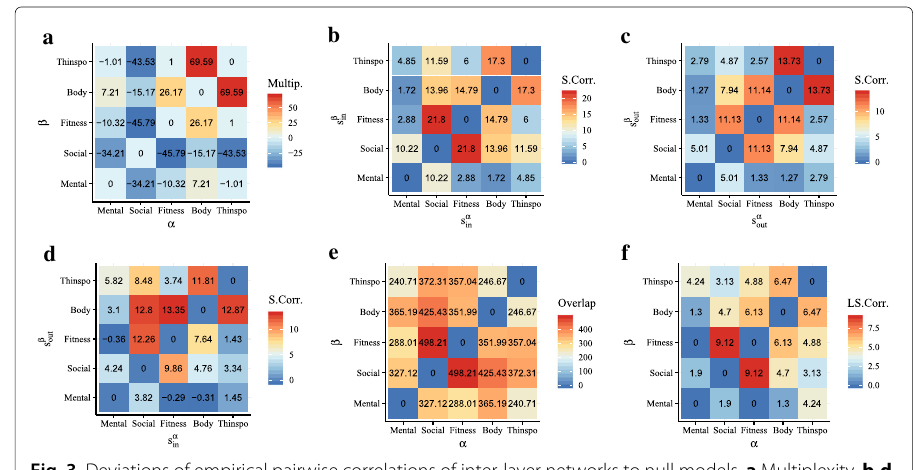
Fig. 3 Deviations of empirical pairwise correlations of inter-layer networks to null models. a Multiplexity, b - d in-/out-strength correlations, e link overlaps and ( f ) correlations of link strengths, where p < 0.05 when z < − 1.96 or z > 1.96 with assumptions of